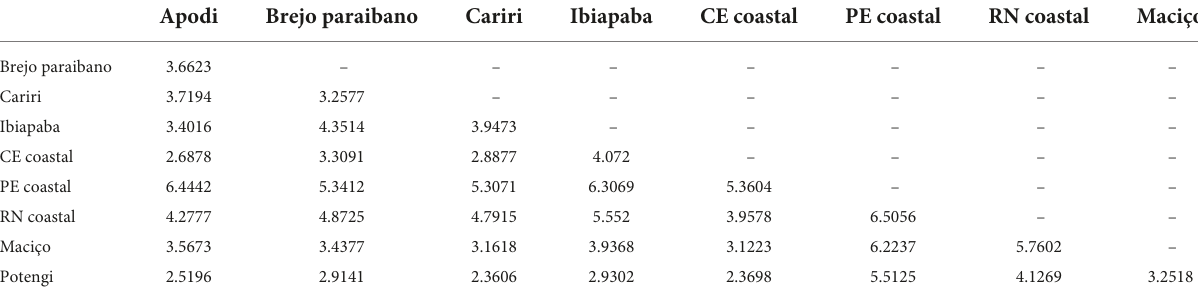
TABLE 3 Squared Mahalanobis distances between the centroids of the analyzed regions.